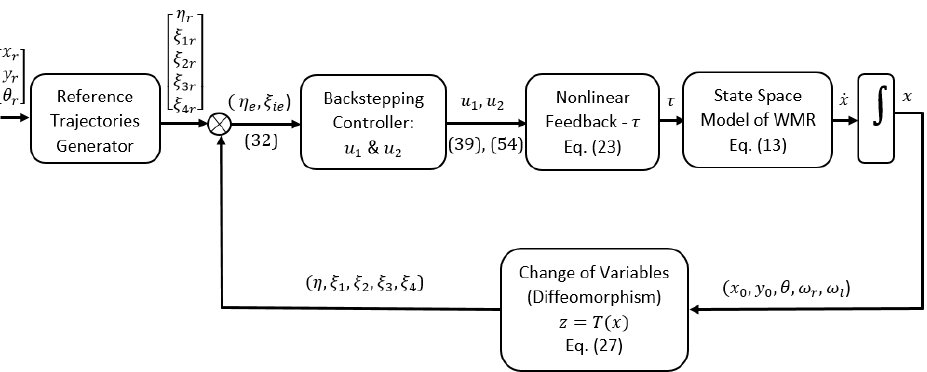
Figure 2. Block diagram of the backstepping controller for stabilization and tracking of WMR.